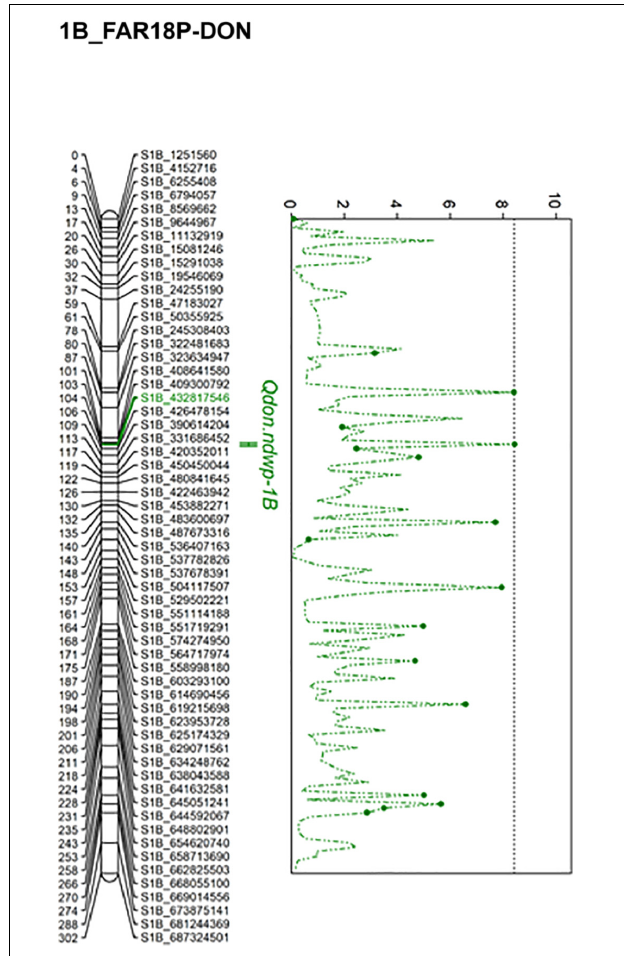
FIGURE 5 | Linkage map for chromosome 1B showing the QTL for resistance to DON accumulation (type III FHB resistance) detected in the Wheaton/Surpresa RIL population. The positions of marker loci are shown on the right and the centimorgan (cM) distances between the loci are shown on the left of the linkage